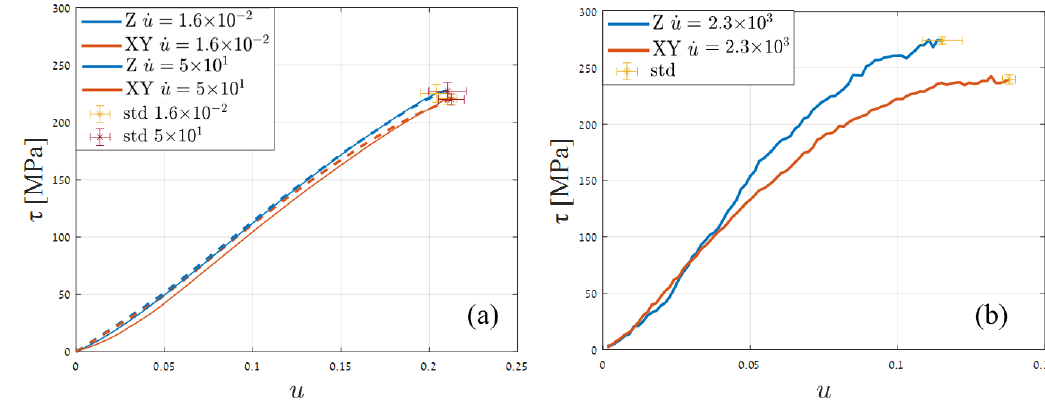
Figure 3 . Results of the shear strength vs. normalized displacement for the XY- and Z-(a) under quasi-static and medium- range loading, (b) under dynamic loading